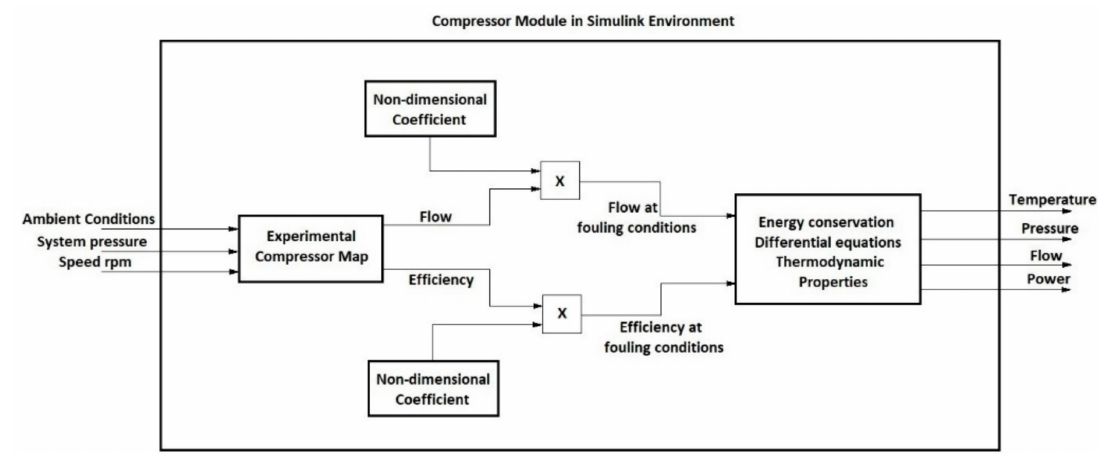
Figure 5. Implementation of non-dimensional coefficients in the compressor